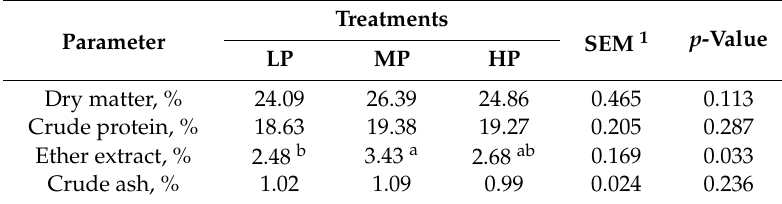
Table 5. E ff ects of three di ff erent dietary protein levels on the nutrient contents of the longissimus dorsi muscle in Tibetan sheep (n = 4 per group).